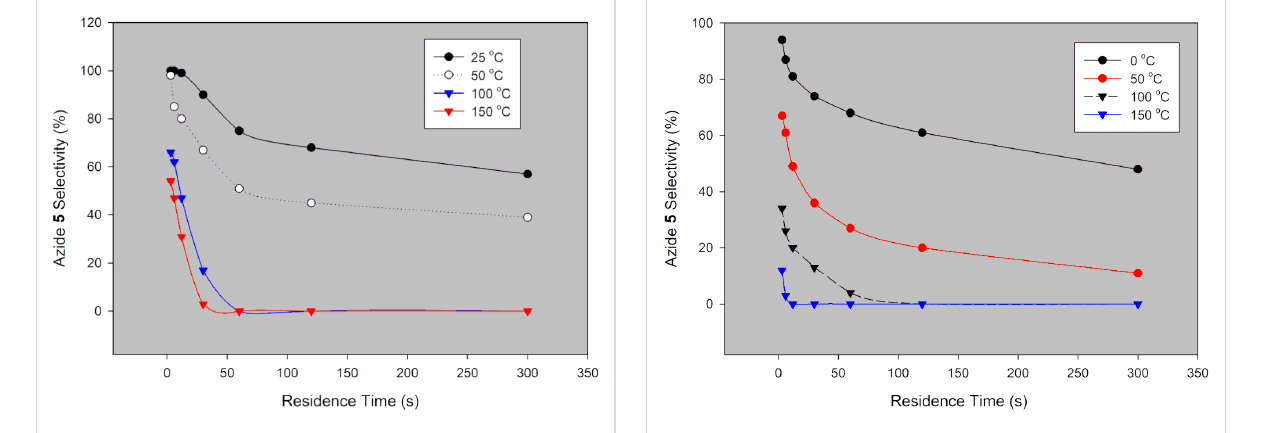
dures was found to be the bottleneck as it lowered azide 5 selec- tivity. Furthermore, TEA is classified as a non-green reagent, which is not ideal [21,22]. In an effort to resolve this, we inves- tigated the use of TBAA for continuous-flow mesyl shikimate 4 azidation as it does not require a base.